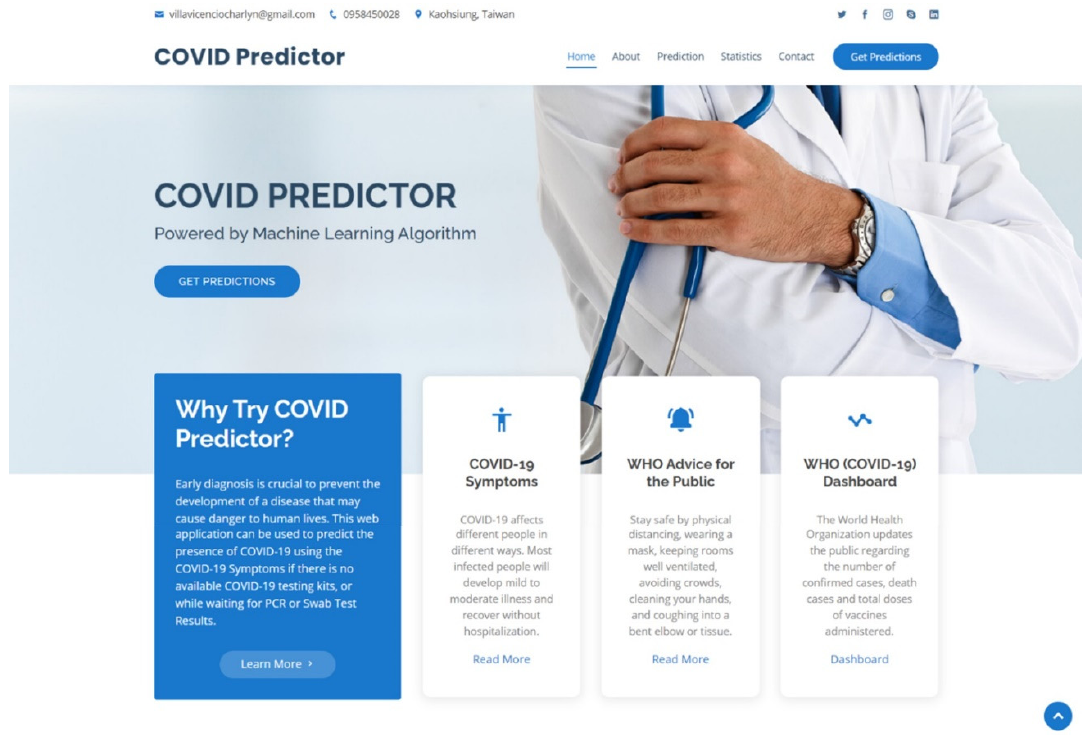
Figure 9. The dashboard, home, or the landing page when a user accessed the web-based application using a browser.